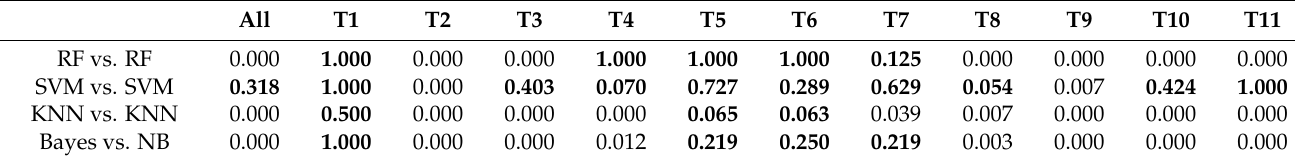
Table 9. McNemar’s test for the same classifier based on different classification